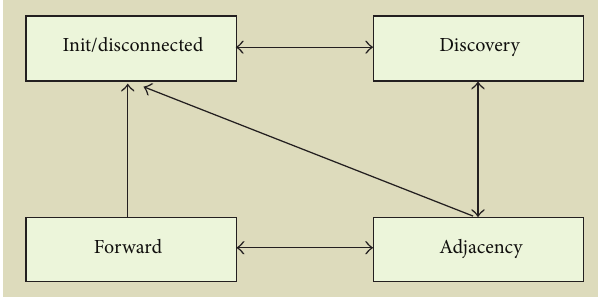
Figure4:Systemprocessesofthemultimediawirelessadhoccluster